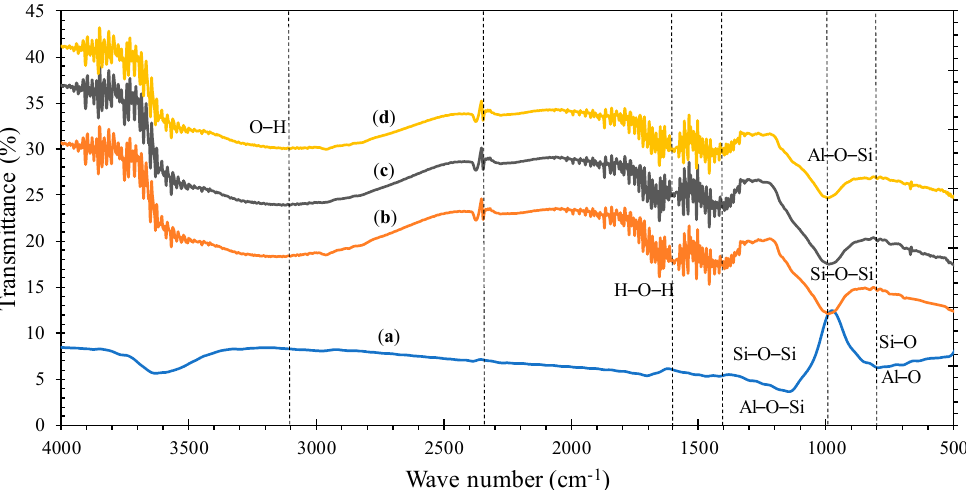
Figure 13. FTIR spectra of the geopolymer paste with various addition of nanosilica, ( a ) 0 wt%, ( b ) 2 wt%, ( c ) 3 wt%, ( d ) 4 wt%.